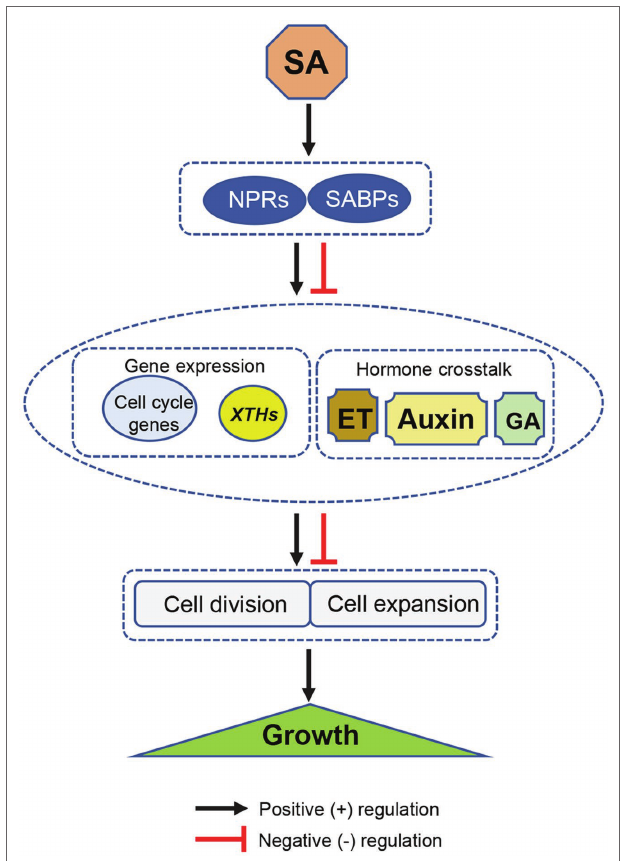
FIGURE 1 | Schematic diagram illustrating a possible mode of SA-induced regulation of cell division and expansion with effects on plant growth. SA positively or negatively modulates cell division and expansion by regulating the transcription of key genes (such as cell cycle related- and cell wall loosening genes XTHs ), and through hormone crosstalk in NPR1-dependent or other SABP-dependent manners. XTHs, xyloglucan endotransglycosylase/ hydrolase genes; NPR1, nonexpressor of pathogenesis-related gene 1; and SABP, SA-binding protein. Black arrows and red T bars indicate positive (+) and negative ( − ) regulation,